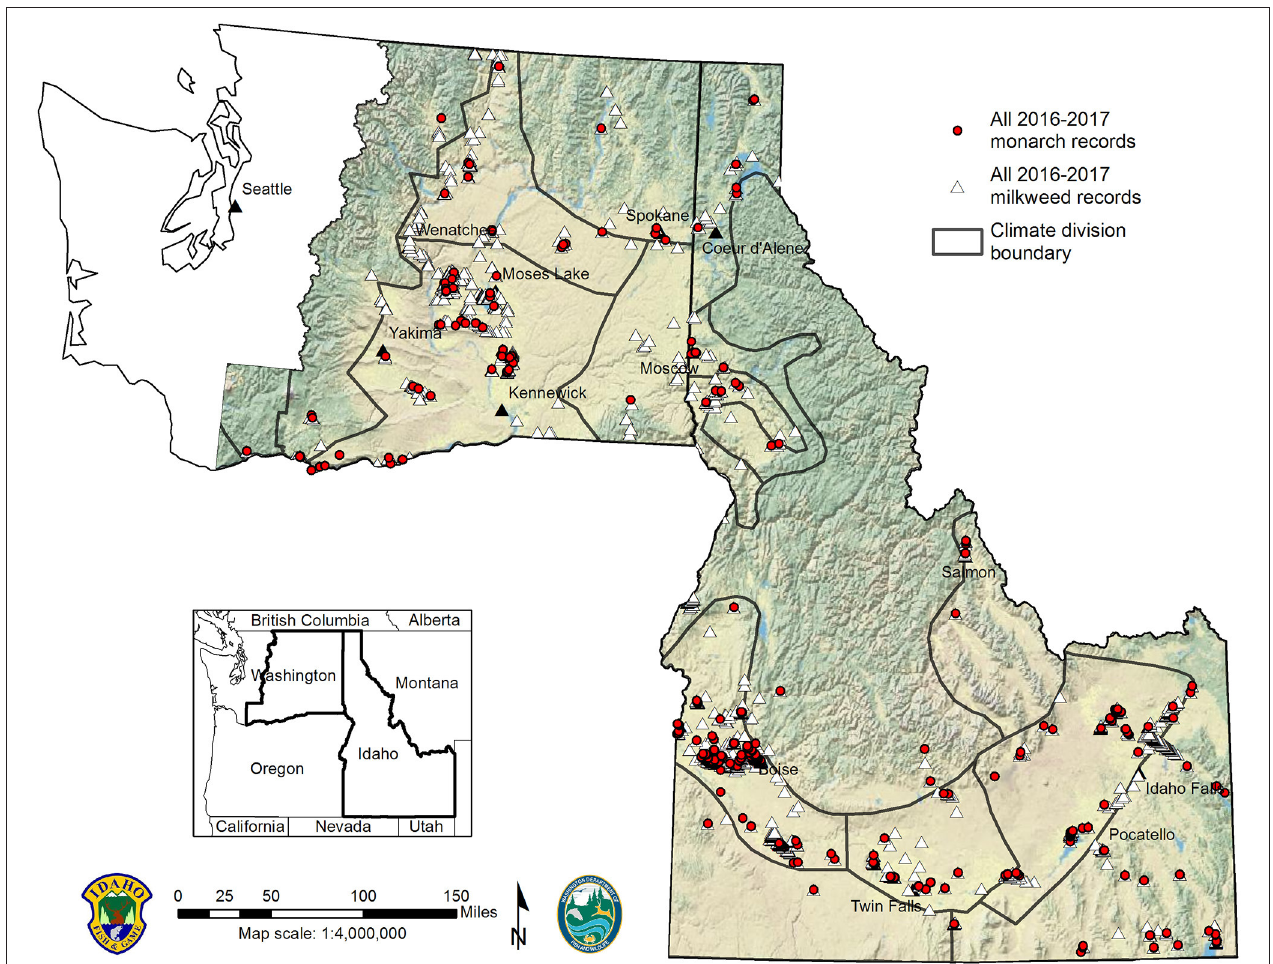
FIGURE 3 | Distribution of monarch and milkweed observations by climate division based on IDFG and WDFW survey data,